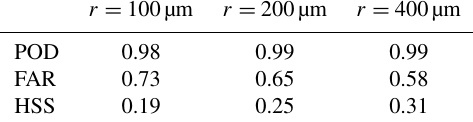
Table 4. Skill scores for comparison of MLC results of radiosound- ing and radar. The skill scores are calculated for the ice crystal sizes r = 100, 200 and 400µm. The values are rounded to two decimal places. r = 100µm r = 200µm r = 400µm POD